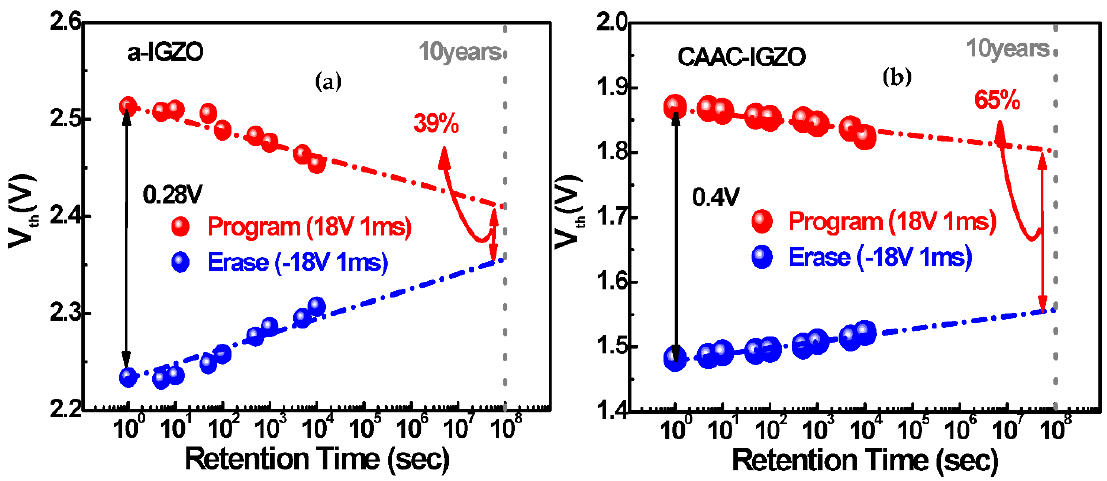
Figure 9. Retention characteristics of ( a ) a -IGZO and ( b ) CAAC-IGZO devices tested up to 10 4 s.